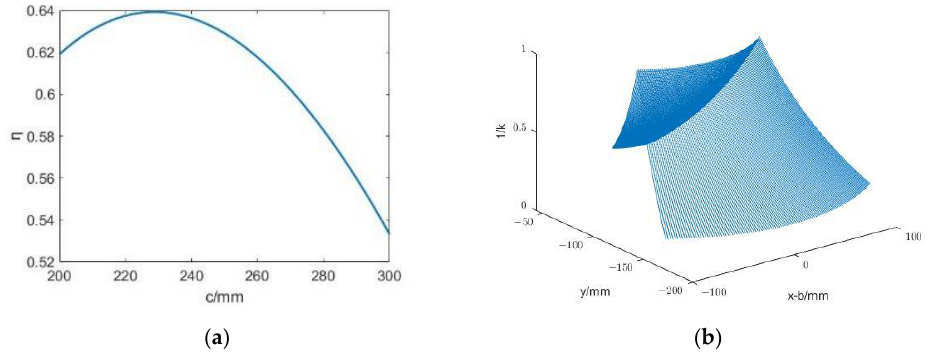
Figure 4. Mechanism motion performance index. ( a ) η varies with c . ( b ) The distributions of 1/k when c = 230 mm .